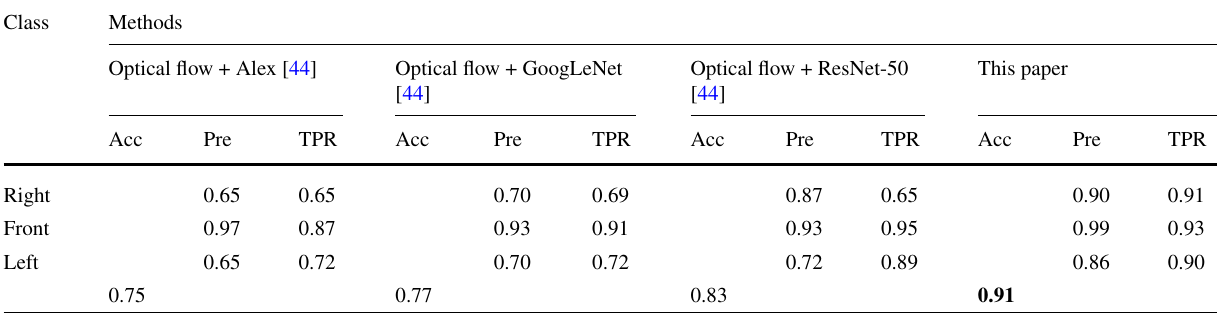
Table 5 Performance comparison of various pedestrian classification algorithms on PDRD data